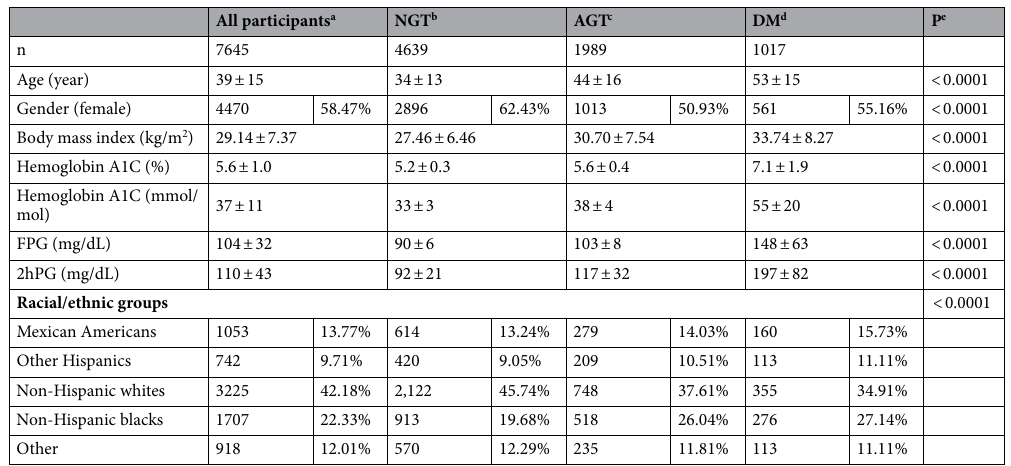
Table 1. Clinical characteristics of included participants. Unweighted mean ± standard deviation or n with percent. NGT normal glucose tolerance, AGT abnormal glucose tolerance, DM diabetes mellitus, FPG fasting plasma glucose, 2hPG 2-h post-challenged plasma glucose. a For all participants: n = 7637 for A1C; n = 3748 for FPG; and n = 2788 for 2hPG. b For NGT: n = 4636 for A1C; n = 1836 for FPG; and n = 1433 for 2hPG. c For AGT: n = 1986 for A1C; n = 1343 for FPG; and n = 1159 for 2hPG. d For DM: n = 1015 for A1C; n = 569 for FPG; and n = 196 for 2hPG. e ANOVA for the three states of glucose